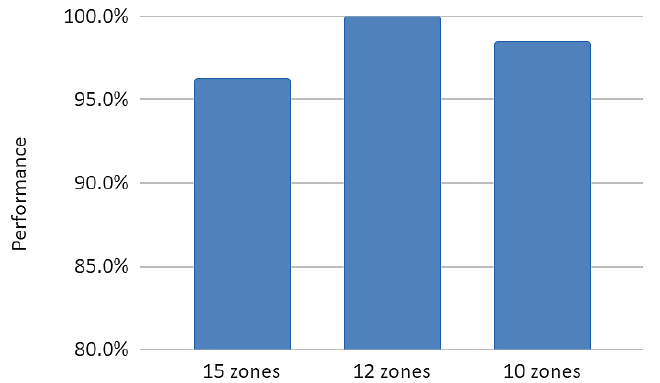
Figure 9. Model performance as a function of number of zones.